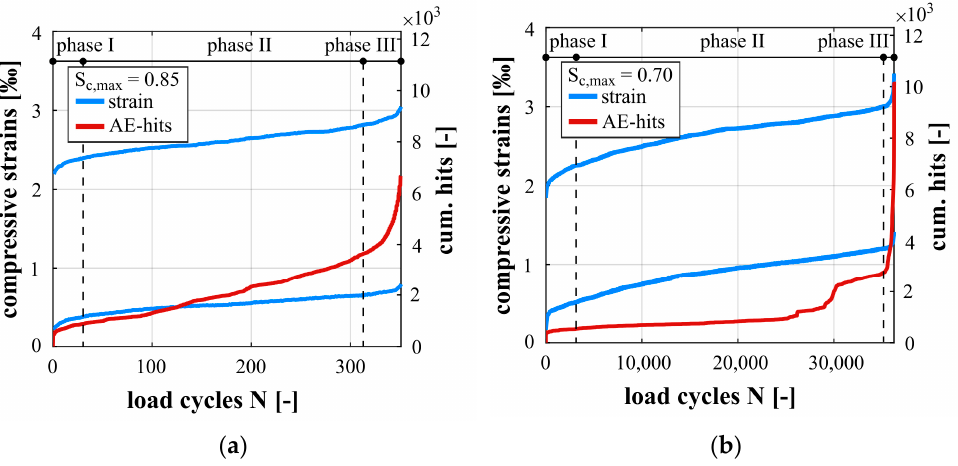
Figure 6. Development of maximum and minimum compressive strains and cumulated AE-hits, for S c,max = 0.85 ( a ) and S c,max = 0.70 ( b